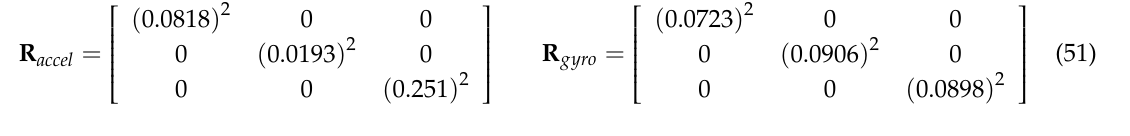
Figure 16. Comparison of IMU measurement and filtered data.